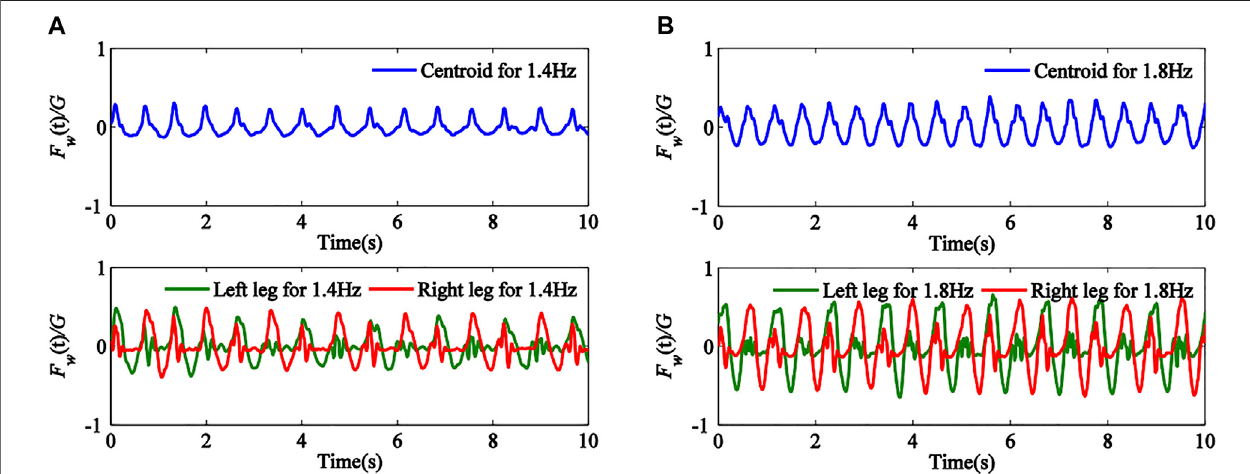
FIGURE 7 | Time histories of non-dimensional pedestrian walking loads for different stride frequencies and measuring positions: (A) 1.4Hz; (B) 1.8 Hz.